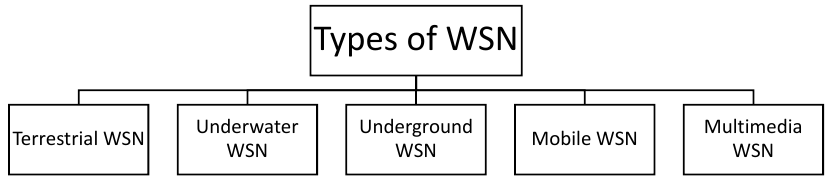
Figure 2. Classifications of WSN.